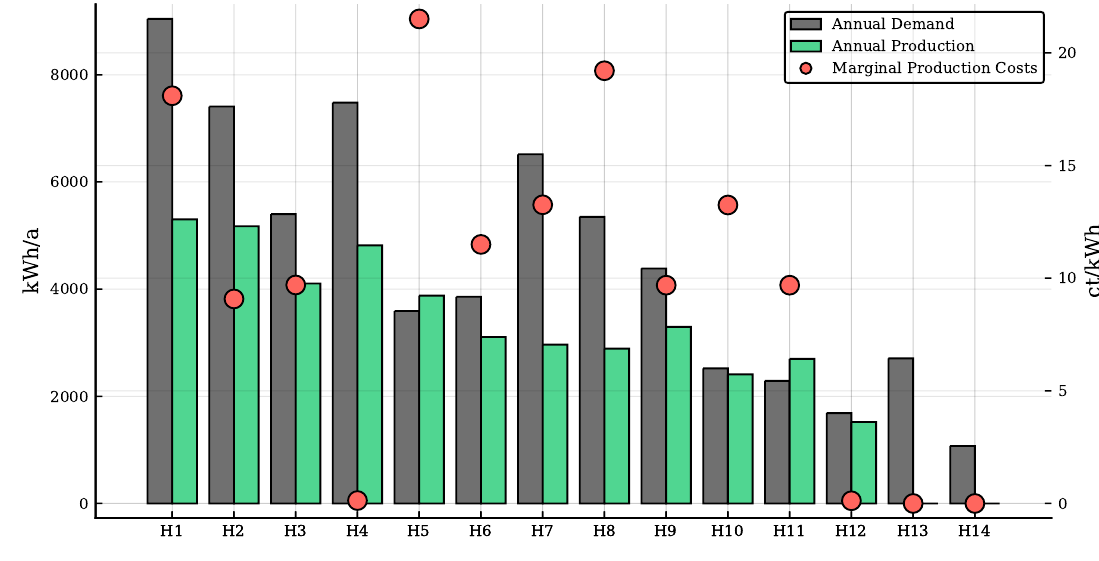
Figure A1. Overview of model